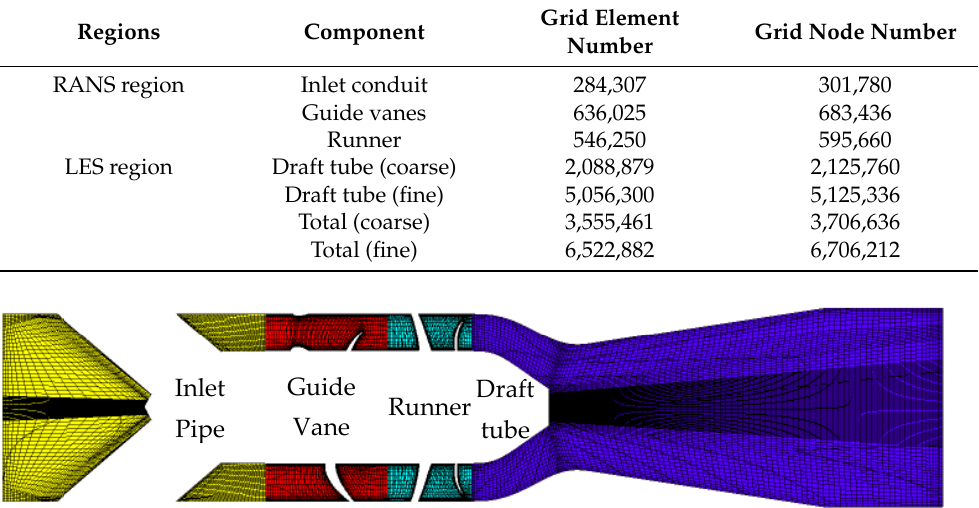
Figure 2. Mesh details on X-Z section.